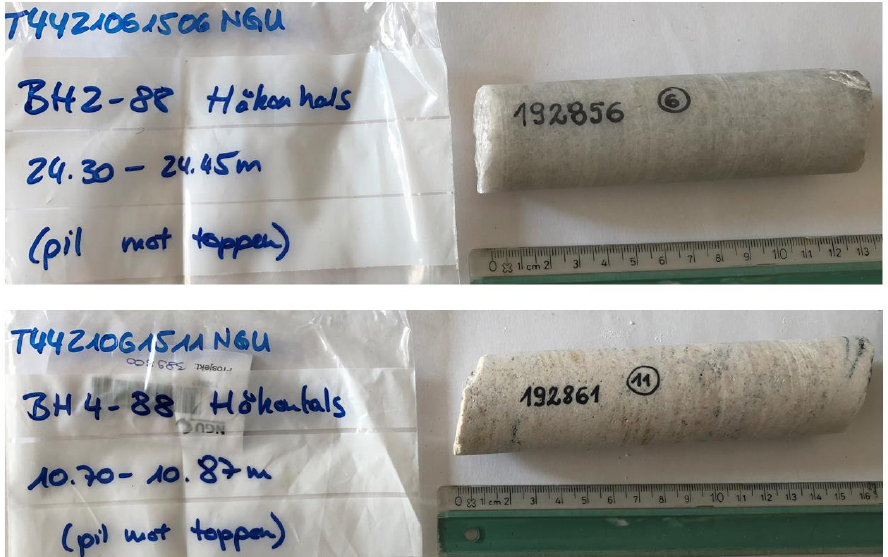
Figure 6. Photographs of two drill core samples from the Håkonhals mine at Tysfjord hosting NYF-type pegmatites. Top: Quartz core of the pegmatite. Bottom: Wall zone of the pegmatite.